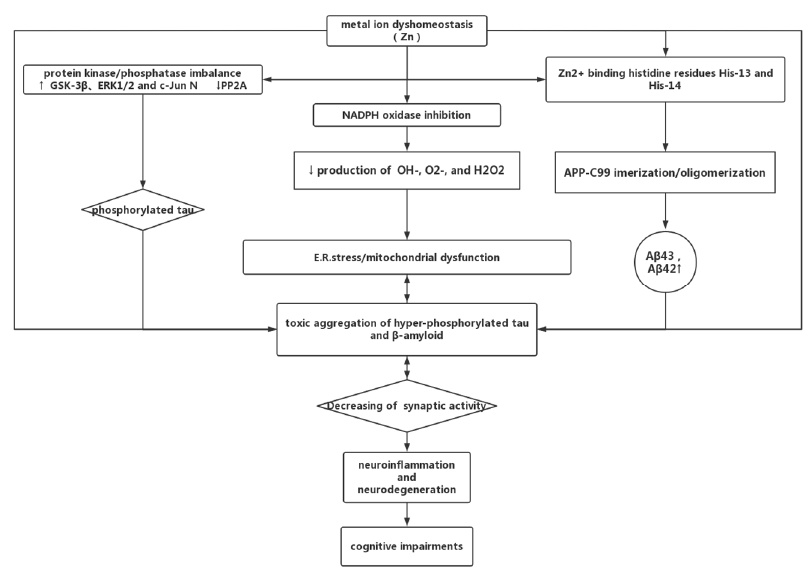
Figure 2. The toxic effects of zinc homeostasis on the pathology associated with AD. Zinc has multiple levels of toxic effects, including oxidative stress and toxic accumulation. Ultimately, cognitive dysfunction is the result.